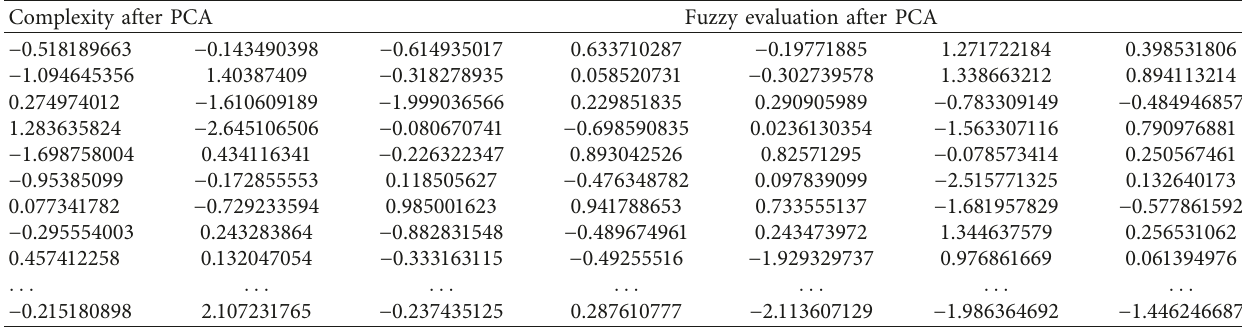
Table 10: Data comparison after dimensions reduction.